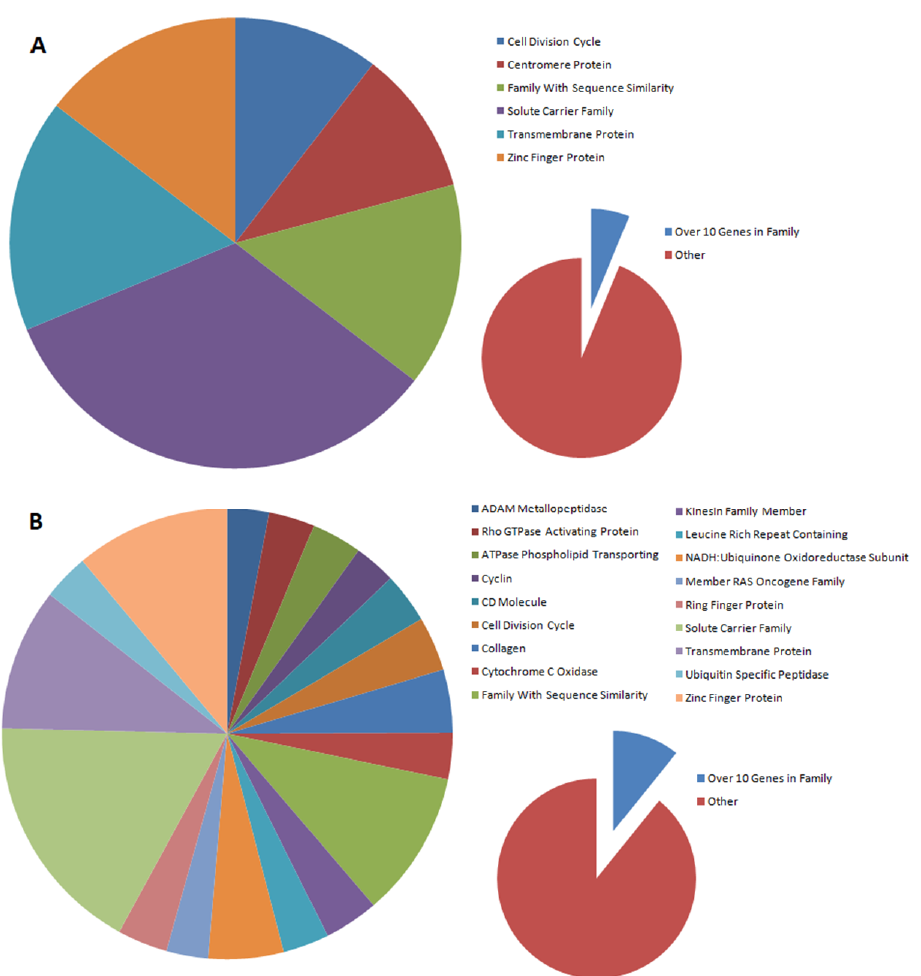
Figure 2. Pie charts that depict the contribution of families with 10 or more genes undergoing expression changes identified following the sarcoid-dependent oncogenic transformation of equine ACFCs triggered by nucleofection with either BPV-E4 ( A ) or BPV-E1ˆE4 ( B ) transgenes. The enrichment analysis performed for the comparison of the incidence of DEGs between control and BPV-E1ˆE4 samples revealed that the focal adhesion GO terms were over-represented by 99 DEGs, 65 of which were upregulated; their 34 counterparts were downregulated (FDR < 0.0001) (Table 2). The GOs, for which most of the genes were recognized as upregulated, have been shown to be related to negative regulation of ex- trinsic apoptotic signaling, transforming growth factor- β receptor signaling, and collagen fibril